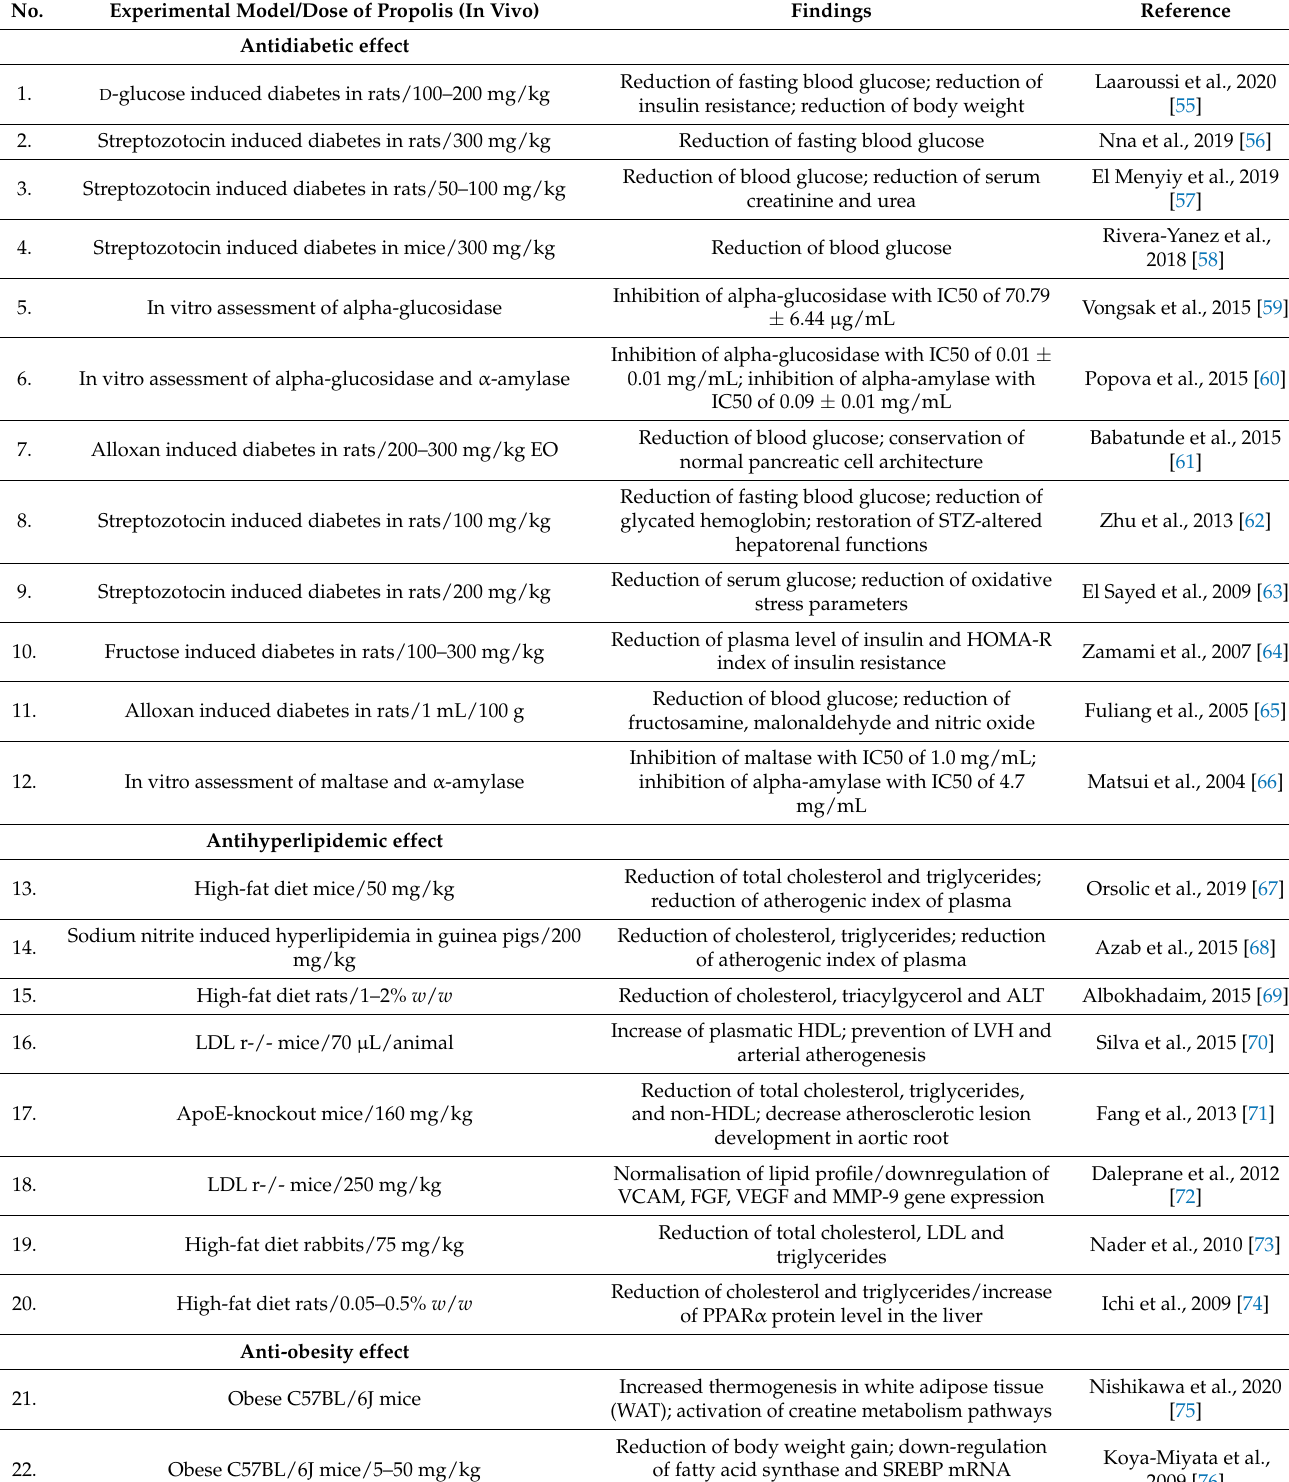
Table 2. Preclinical studies (in vivo and in vitro) investigating the effect of propolis in metabolic diseases.